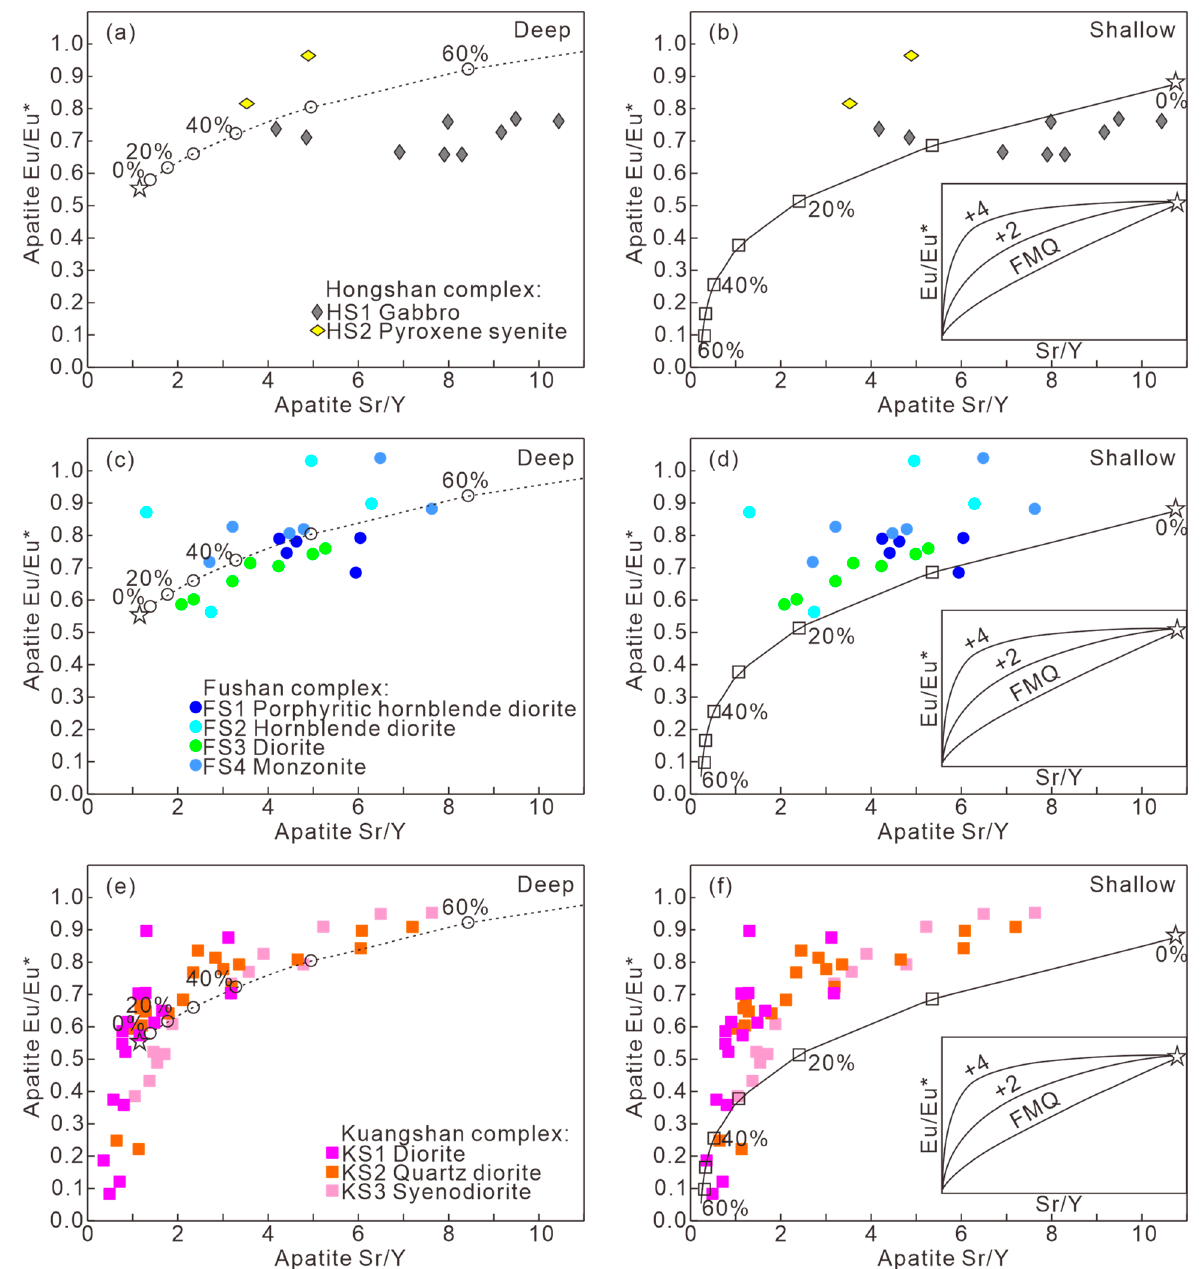
Figure 9. Diagrams of Sr/Y-Eu/Eu* in apatite. The deep fractional crystallization model (amp (66%) cpx (34%)) for the Hongshan ( a ), Fushan ( c ), and Kuangshan ( e ) complexes, the shallow fractional crystallization model (amp (23%) pl (77%)) for the Hongshan ( b ), Fushan ( d ), and Kuangshan ( f ) complexes. The data of the Hongshan complex is quoted from [78–80]. The start of each fractionation path and percentage of crystallization is from [7].